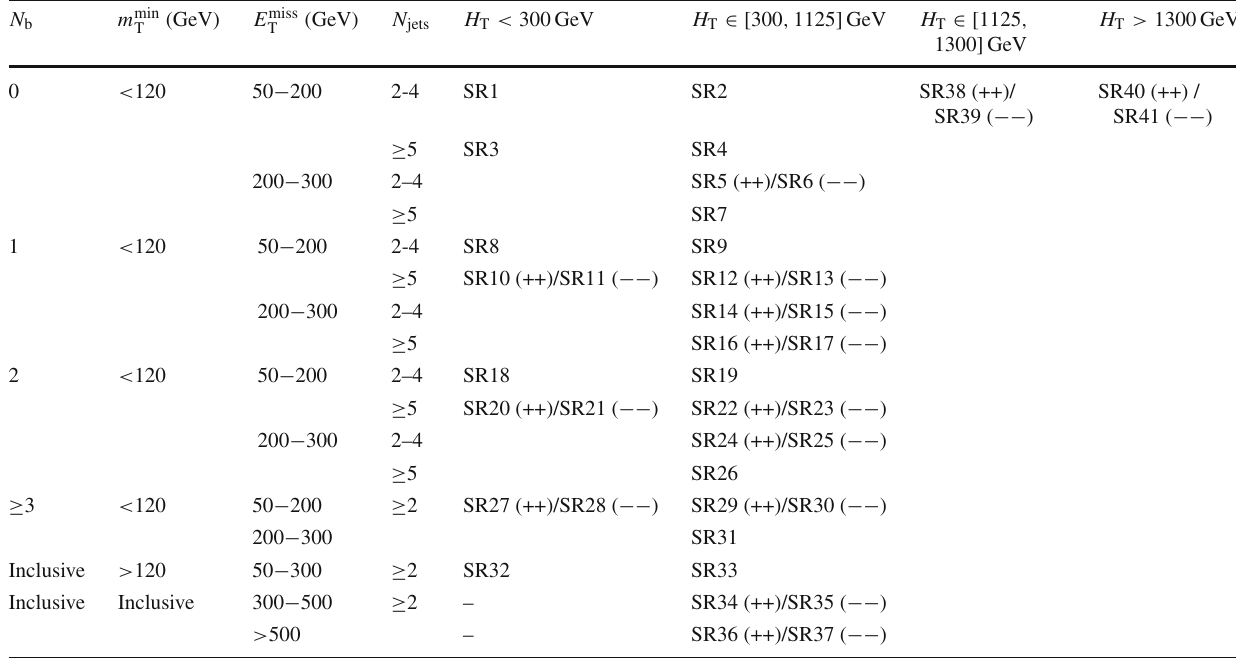
Table 3 Signal region definitions for the HL selection. Regions split by charge are indicated with ( ++ ) and ( −− ). All unlabeled region are included in the SR above them, for example the unlabeled regions